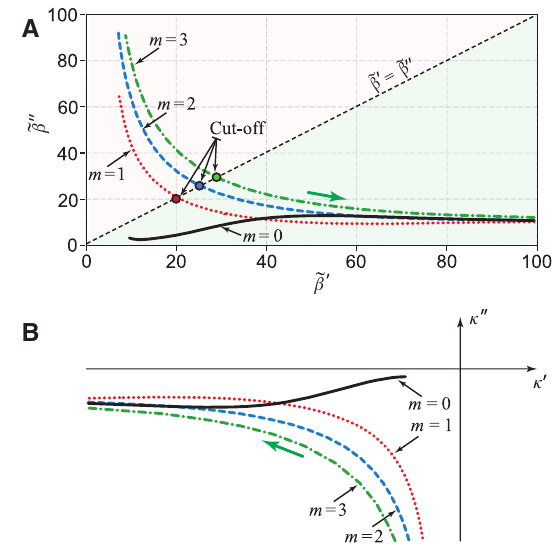
Figure 5: Roots appearance of surface plasmons. Roots of the dispersion equation of the TM modes of surface plas- mons in the graphene-coated nanowire plotted in the complex (A) β β −′ ′′   and (B) κ ′ − κ ″ planes. Bold green arrows are directed toward the increasing frequency. The area filled in light green corresponds to the region of propagating modes; a = 50